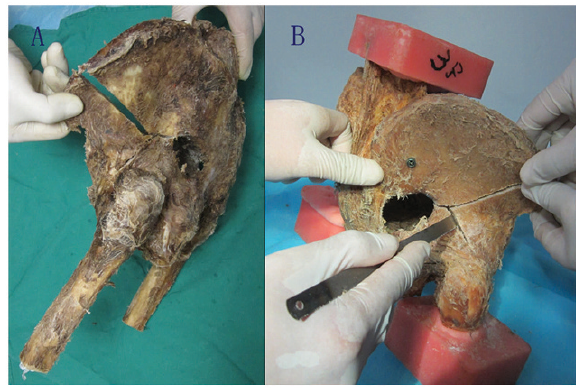
Figure 3 - Cadaver fracture model of high column fracture. (A. lateral, B. making